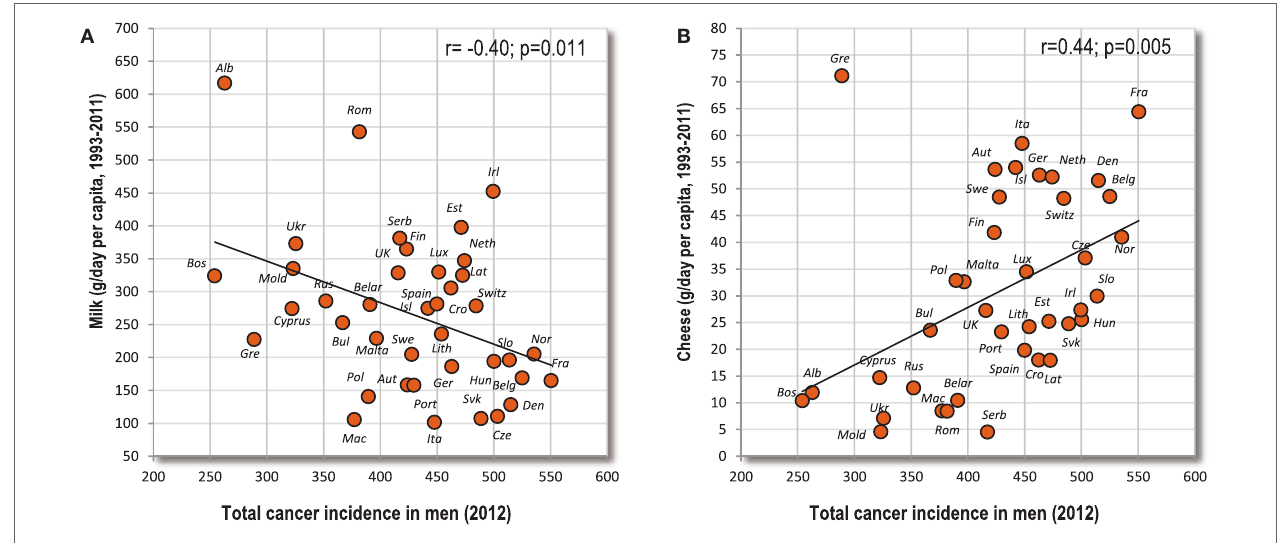
FigUre 11 | (a,b) Relationship between various dairy products (milk, cheese) and total cancer